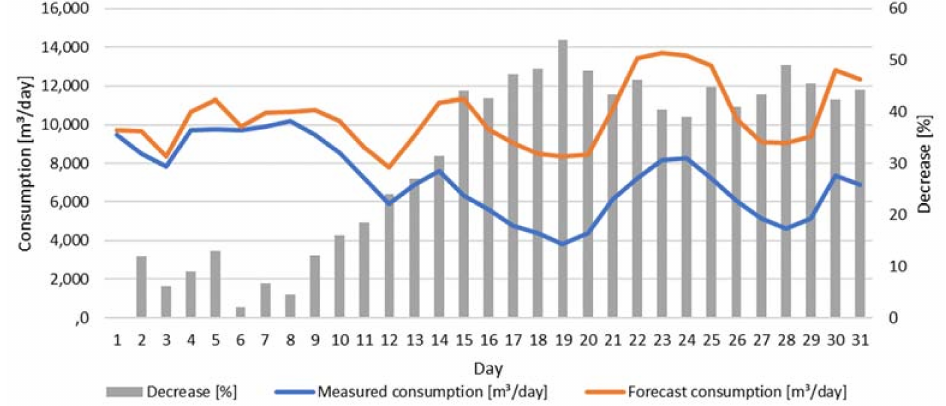
Figure 14. Forecast consumption vs. actual consumption in March 2020 after